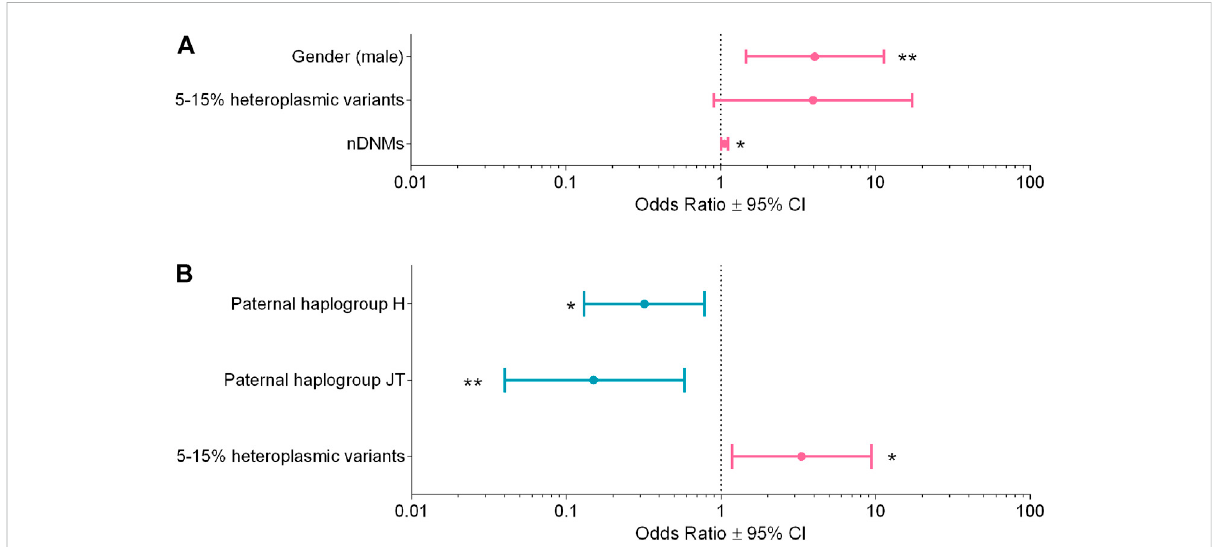
FIGURE 4 Multivariable logistic regression analyses for ASD susceptibility and severity. (A) Analysis for ASD susceptibility, R 2 = 0.17. (B) Analysis for ASD severity R 2 = 0.14. Odds ratios (OR ± 95% CI) calculated with the multivariable logistic regression are shown in the fi gure; the variables reducing risk are in blue, whereas those increasing risk are in magenta. * p -value < 0.05, ** p -value <